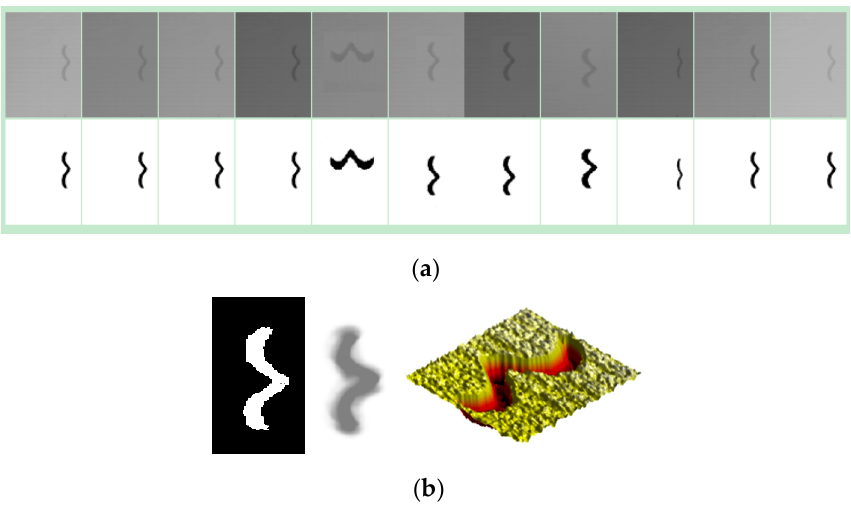
Figure 13. Experimental results for training data sets and predicted reconstruction images. ( a ) Training samples for crack based on the devised data augmentation in 3D-LDS; ( b ) Predication map (left) with its binary image (middle) and the 3D visualization (right) for the inspected L-crack defect.